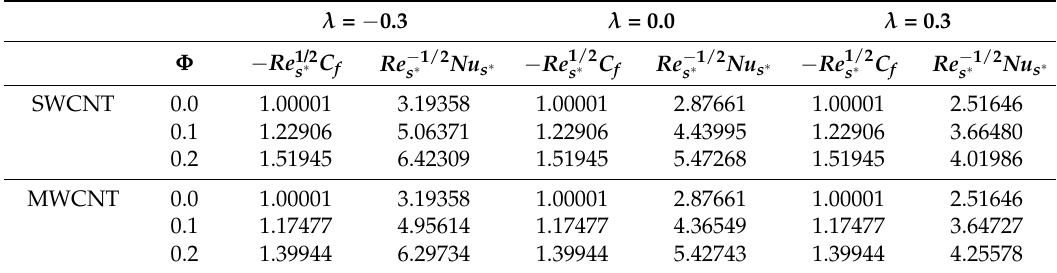
Table 4. Comparison of − Re 1/2 and κ = 1000 fixed.